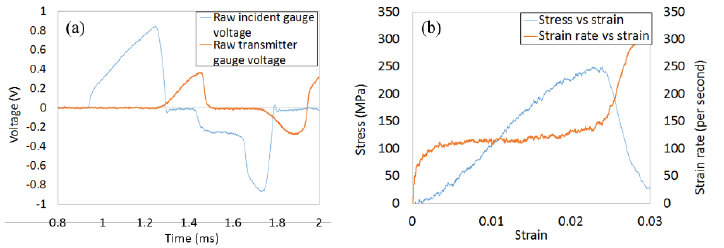
Figure 1 : Schematic of a CiT striker in a typical SHB setup.